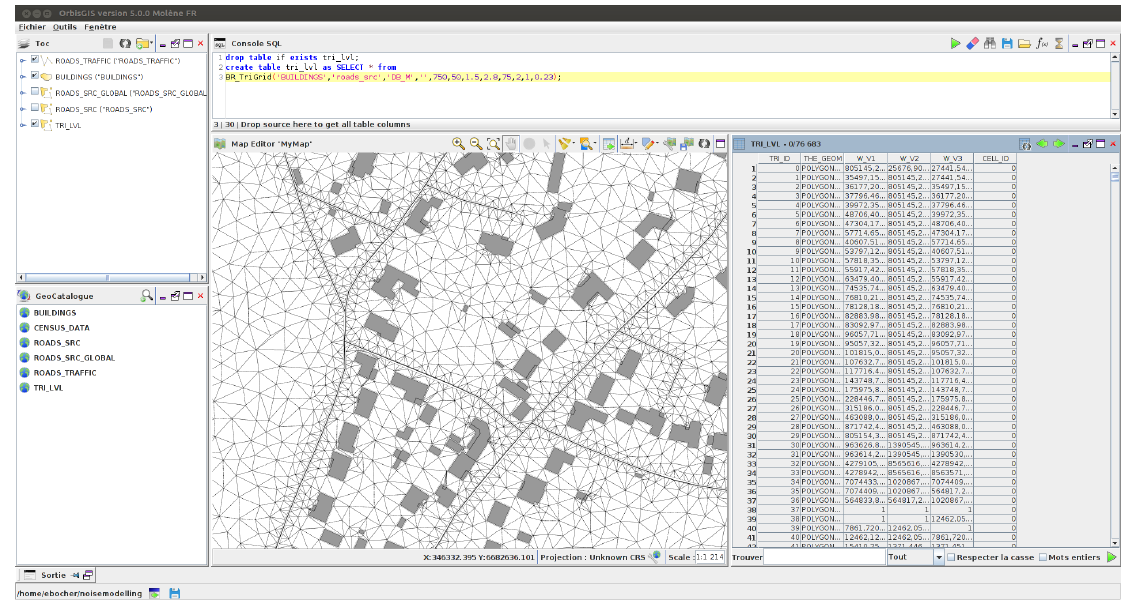
Figure 10. Example of the results of the BR_TriGrid function in the OrbisGIS platform.